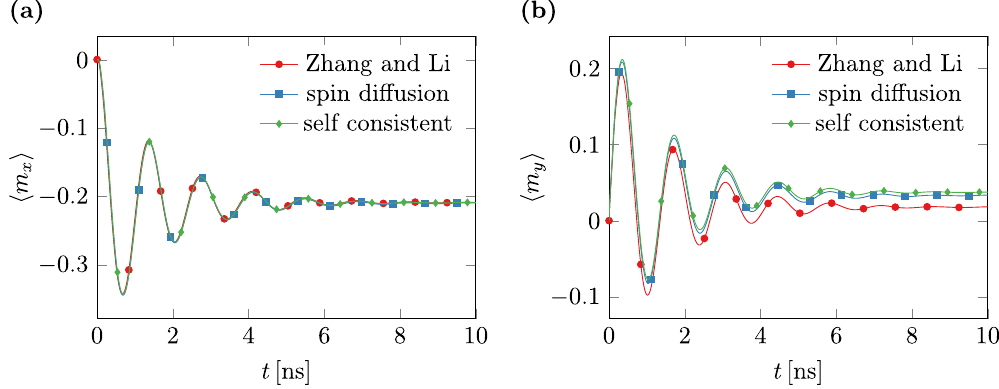
Figure 2. Results for the standard problem #5 for different micromagnetic models. Time evolution of the averaged magnetization components. ( a ) x -component ( b ) y